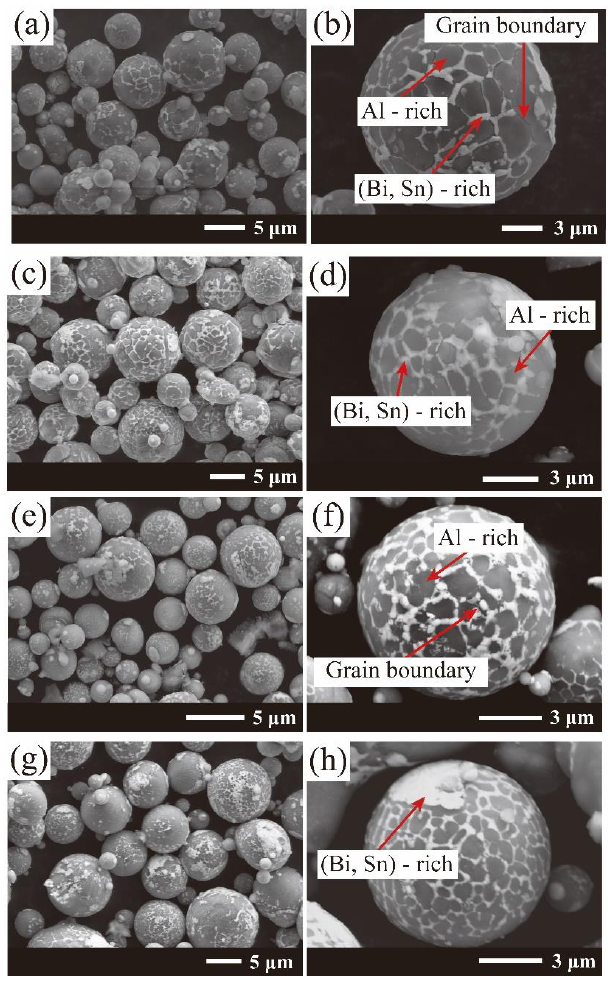
Figure 3. SEM images of the as-atomized Al-10Bi-7Sn-xFe (x = 0, 0.5, 1.5, 3) (wt.%) composite powders: ( a ), ( b ) Al-10Bi-7Sn (wt.%) [33]; ( c ), ( d ) Al-10Bi-7Sn-0.5Fe (wt.%); ( e ), ( f ) Al-10Bi-7Sn-1.5Fe (wt.%); ( g ), ( h ) Al-10Bi-7Sn-3Fe (wt.%).